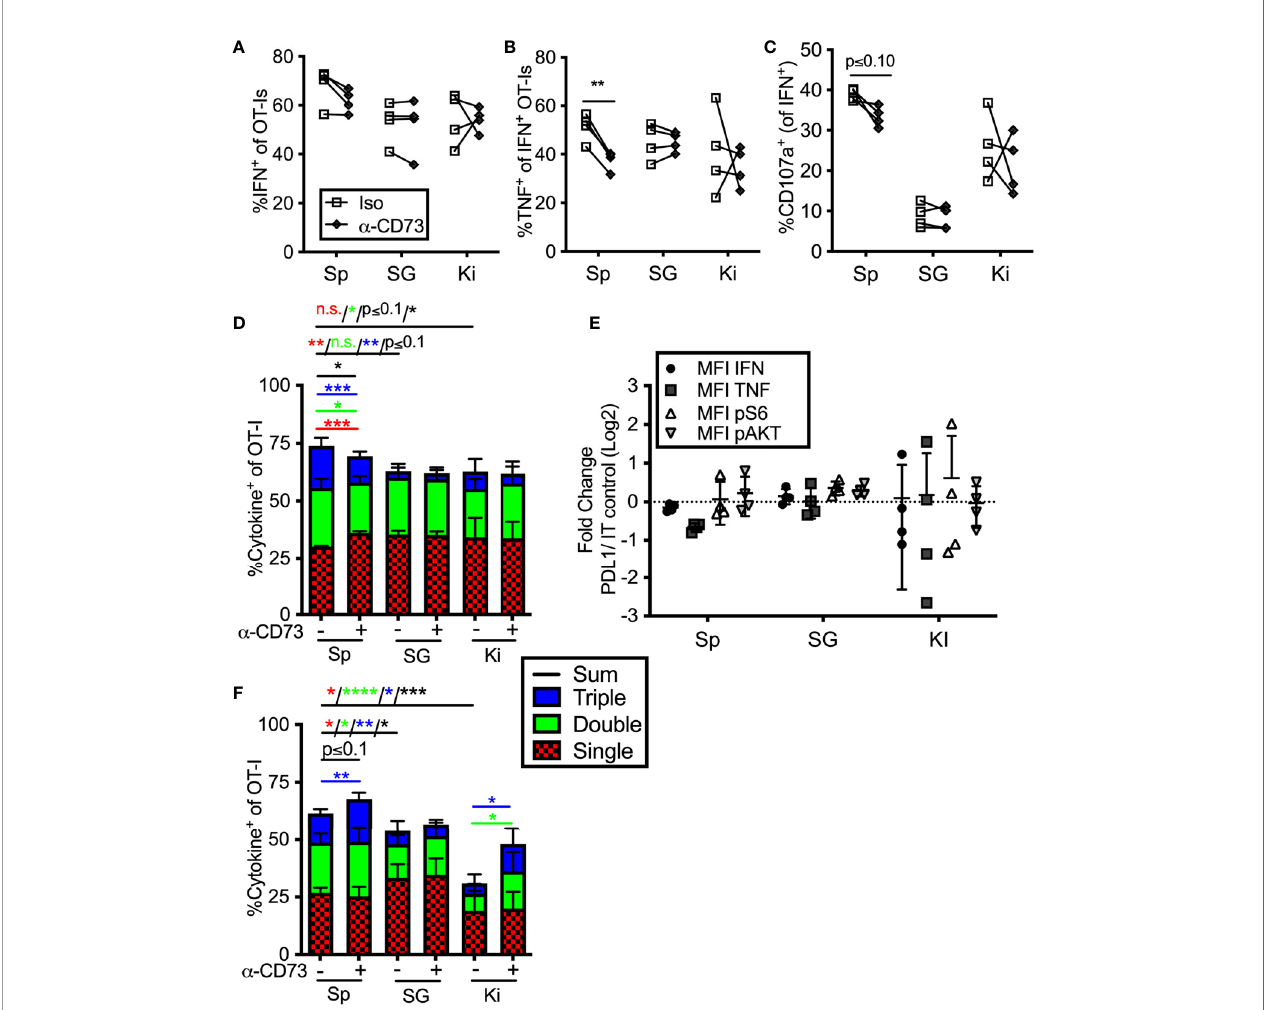
FIGURE 5 | Impact of blocking CD73 on T cell function ex vivo . (A – E) Mice were seeded with OT-Is and infected with MCMV-OVA. At least 3 months post infection OT-Is were harvested from the indicated organs and stimulated for 5 hours with SIINFEKL pulsed DC2.4s in the presence of anti-CD73 or and isotype control antibody (iso). (A) Frequency of OT-Is that produced IFN- g , or (B) co-produced IFN- g and TNF- a or (C) produced IFN- g and exposed CD107a during stimulation. Each line connects OT-Is from the same mouse. Data were analyzed in pairwise fashion using paired, two-tailed t-tests to assess differences between cells recovered from different organs of the same mouse, or cells recovered from a single organ and restimulated with or without blocking antibody, (n=4 from 2 independent experiments). (D) Boolean gating of OT-Is expressing IFN- g , TNF- a and/or CD107a after stimulation. Populations expressing 1, 2, and/or 3 functions were analyzed by paired two-tailed t-tests. (n=4 from 2 independent experiments). (E) Fold change in mean fl uorescence intensity of the indicated marker of anti- CD73 treated OT-Is relative to isotype control antibody treated controls from the cells shown in (A – C) . As in Figure 4 , the MFI of the indicated molecules were compared across experiments as the ratio between cells treated with the blocking antibody vs cells treated with the isotype control antibody. Therefore, a value of 1 indicates no change between treated and control wells. Statistical comparisons were conducted using one sample t-tests between each condition and a hypothetical value of 1 (n=4 from 2 independent experiments). (F) Mice were seeded with OT-Is and infected with MCMV-OVA. At least 3 months after infection, mice were treated with anti-CD73 blocking antibody or isotype control for 2 weeks. Lymphocytes were isolated from the indicated organs and stimulated for 5 hours with SIINFEKL pulsed DC2.4s in the presence of the same antibody that was injected into the mice. Shown is Boolean gating of OT-Is expressing IFN- g , TNF- a and/or CD107a after stimulation. Since cells were derived from different mice treated with isotype control antibody or CD73 blocking antibody, populations expressing 1, 2, and/or 3 functions were analyzed by unpaired two-tailed t-tests. Data are from n=6 mice from 2 independent experiments). *p ≤ 0.05, **p ≤ 0.01, ***p ≤ 0.001, ****p ≤ 0.0001, n.s., not signi fi